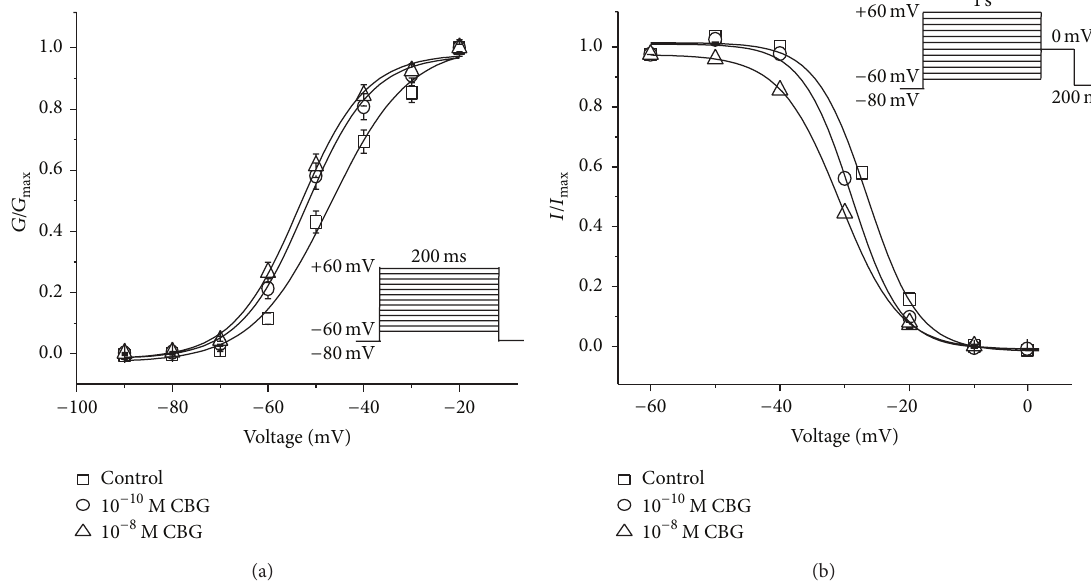
Figure 6: Effects of CBG on voltage-gated LTCCs in isolated rat left ventricular myocytes. (a) The steady-state activation of LTCCs shifted left by application of 10 −10 and 10 −8 M CBG. Tail currents were elicited by depolarization to − 60mV after 200 ms test pulses from − 60 to 0mV in increments of 10mV. (b) CBG shifted the steady-state inactivation curve of LTCCs to the hyperpolarizing direction. The voltage protocol included double pulses consisting of a 200 ms test pulse to 0 mV following a 1s conditioning pulse varying from − 60 to 60 mV with 10mV increments. Data are presented as means ± S.E.M. ( 𝑛 = 8